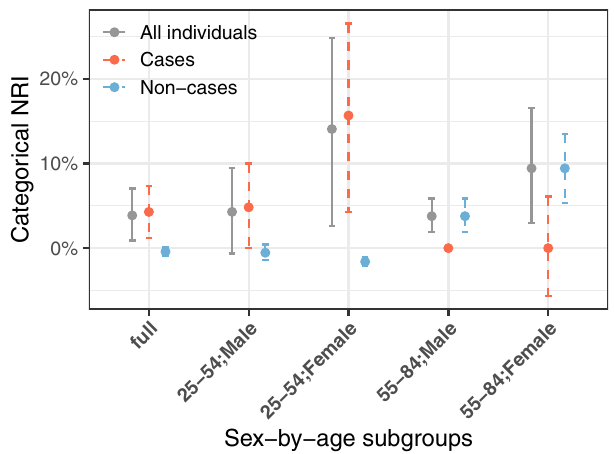
Fig. 4 | Net reclassi fi cation index (NRI) for coronary artery disease with the addition of a polygenic score to QRISK3. Estimates for categorical NRI for the integrated score compared to QRISK3 in all samples ( n =420 unrelated cases and 7702 unrelated non-cases) as well as in age-by-sex subgroups ( n =207 and 2779 in males aged 25 – 54; n =51 and 4187 in females aged 25 – 54; n =114 and 344 in males aged55 – 84; n =48and 392infemalesaged 55 – 84)are shown. RedindicatesNRI in cases and blue in controls. The error bars indicate 95% con fi dence intervals esti- mated using the bootstrap observed a positive categorical NRI (3.33%; 95% CI: 0.01 – 6.74) for the integrated score (Supplementary Data 13).